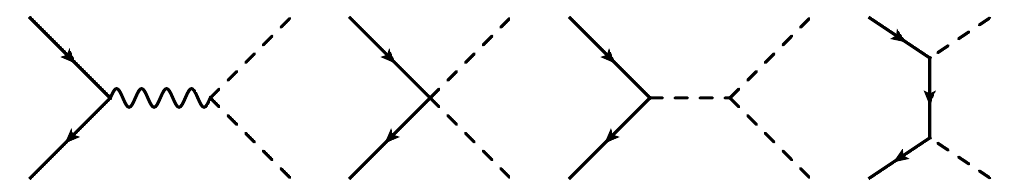
Figure 2 . Representative diagrams for q